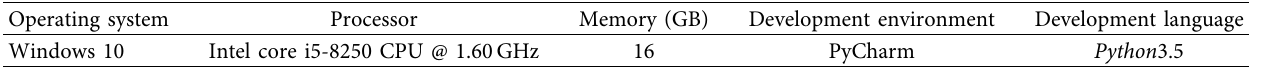
Table 2: Development